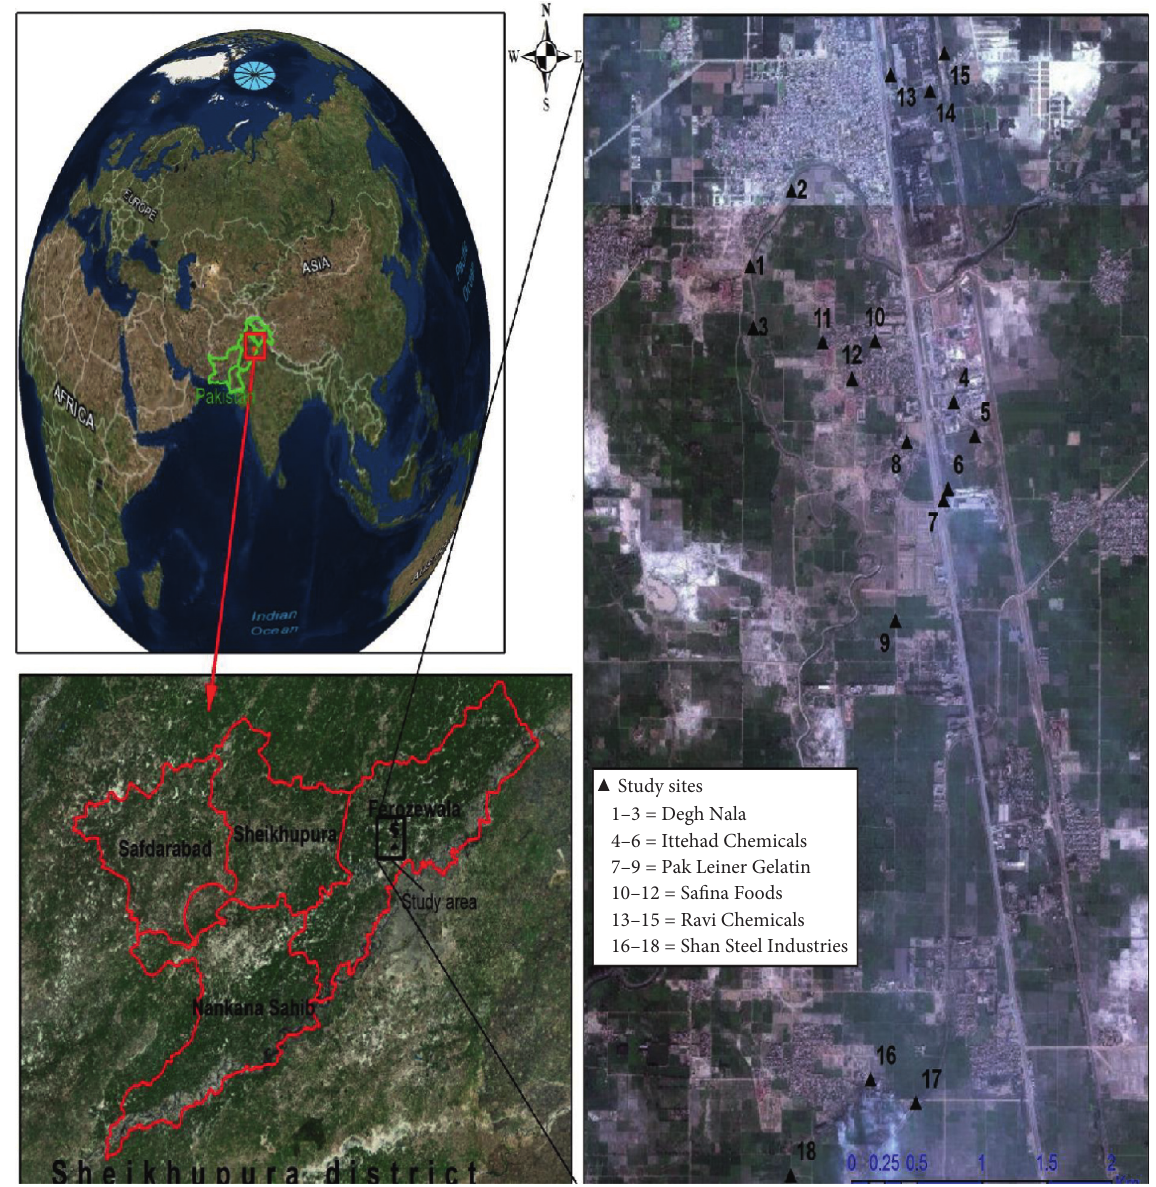
Figure 1: Wastewater sample collection points in Kala Shah Kaku industrial